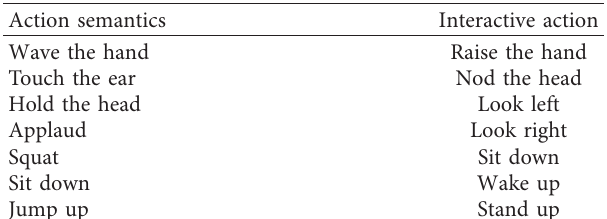
Table 5: Correspondence between action semantic and interactive